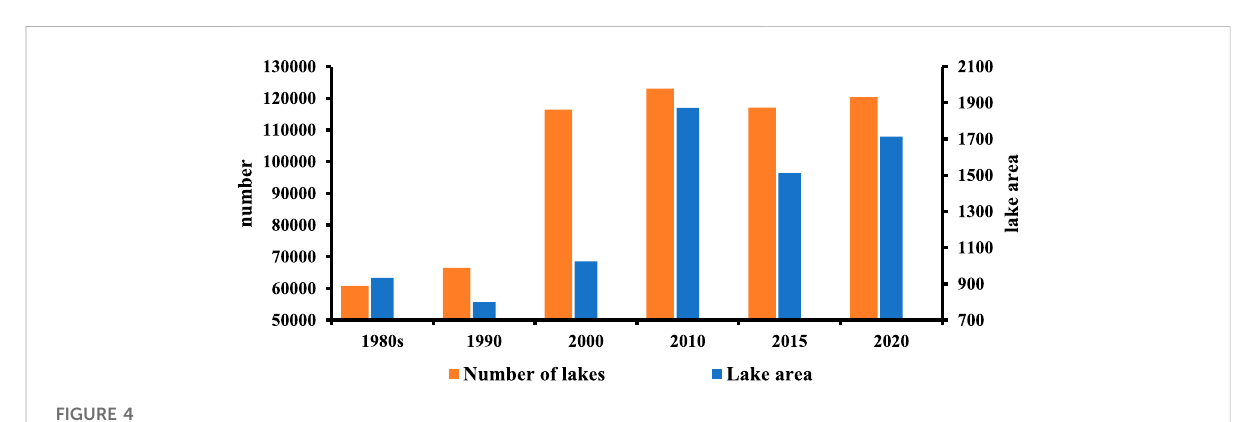
FIGURE 3 Thermokarst lakes in 2020.